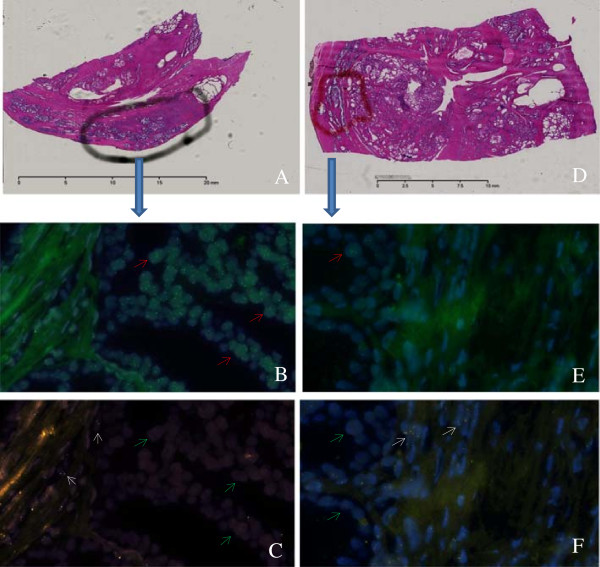
Representative images of FISH and H&E staining from tumour and histologically benign areas of the same case. A: an H&E image of a tumour section (from Case 01, tumour block) with the area of tumour circled; B: MYC amplification (green signals indicated by the red arrow) and DAPI nuclear staining (blue) in a representative field of view of the tumour section; C: PTEN deletion indicated by green arrows and DAPI nuclear staining (blue) in a representative field of view of the tumour section (gold PTEN signals are visible only in stroma cells); D: an H&E image of the histologically benign section (from Case 01, histologically benign block) with the area that has abnormal FISH signals circled; E: MYC amplification (green signals indicated by the red arrow) and DAPI nuclear staining (blue) in a representative field of view of the histologically benign section; F: PTEN deletion indicated by green arrows and DAPI nuclear staining (blue) in a representative field of view of the histologically benign section (gold PTEN signals are visible only in stroma cells, indicated by white arrows).